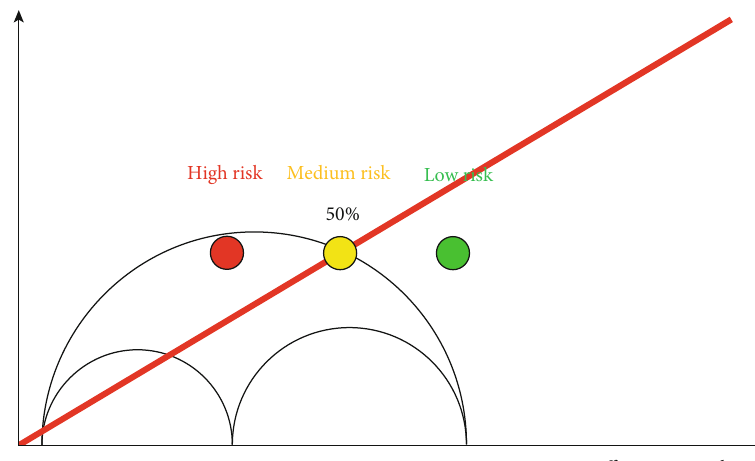
Figure 10: The stress state of faults with di ff erent slip risks.